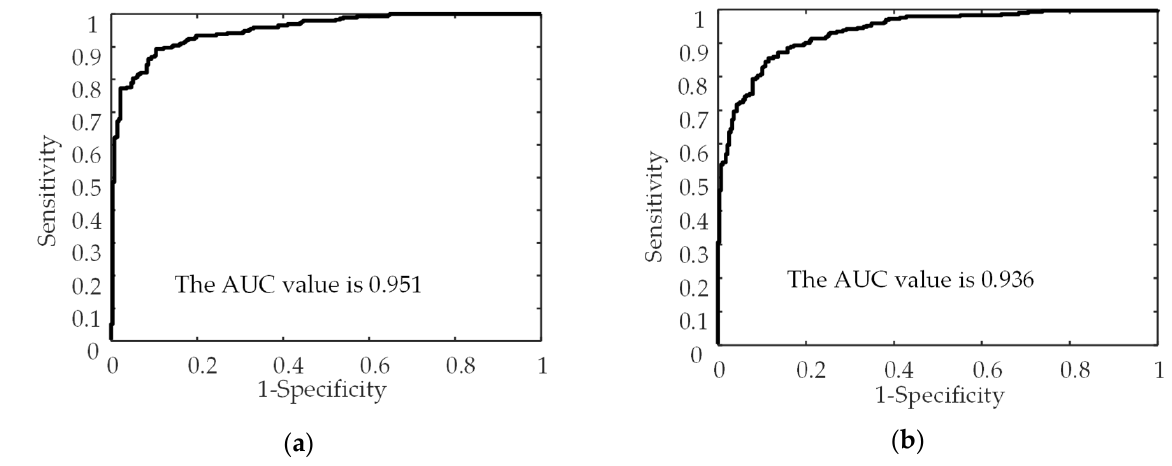
Figure 6. ROC curve. ( a ) ROC curve of RF algorithm. ( b ) ROC curve of BPNN algorithm.